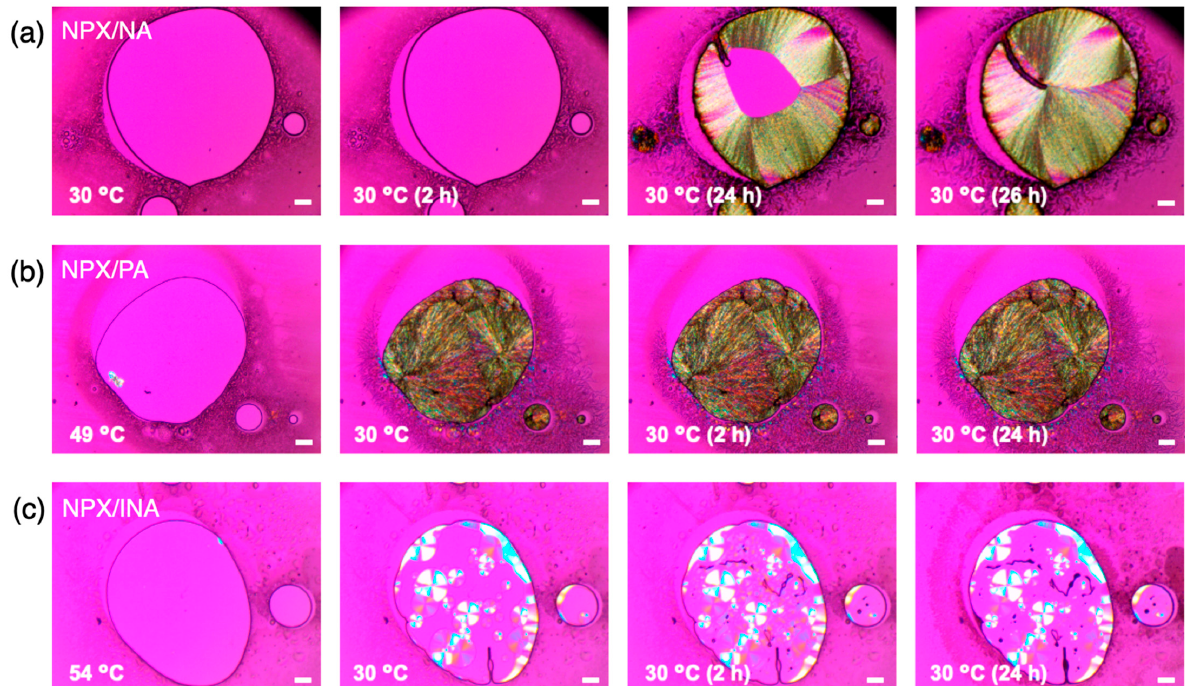
Figure 4. Optical microscope (OM) micrographs during melt crystallization of the cocrystals of ( a ) NPX/NA (2:1), ( b ) NPX/PA (1:1), and ( c ) NPX/INA (1:1). The observation was under cross polarization, and all scale bars are 100 μ m. Note that the crystallization of NPX/PA and NPX/INA cocrystals started during cooling at about 49 °C and 54 °C, respectively.